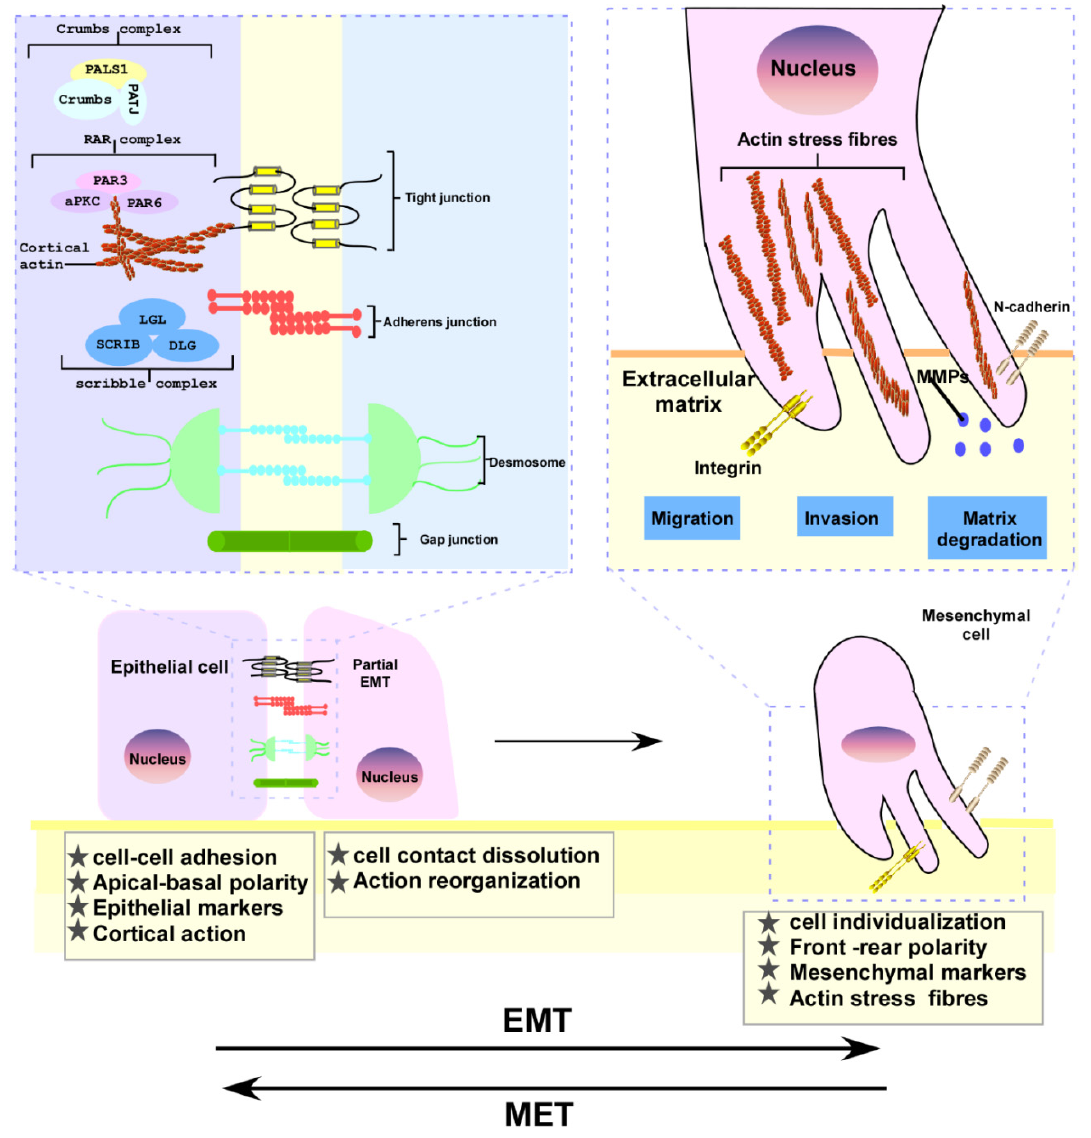
Figure 3. Schematic diagram of EMT plasticity during metastasis of cancer cells. In this process, the tight junctions, adhesions, desmosomes, and gap junctions are gradually dissolved. In the meantime, N-cadherin, MMPs, and integrin are upregulated to promote migration and invasion.